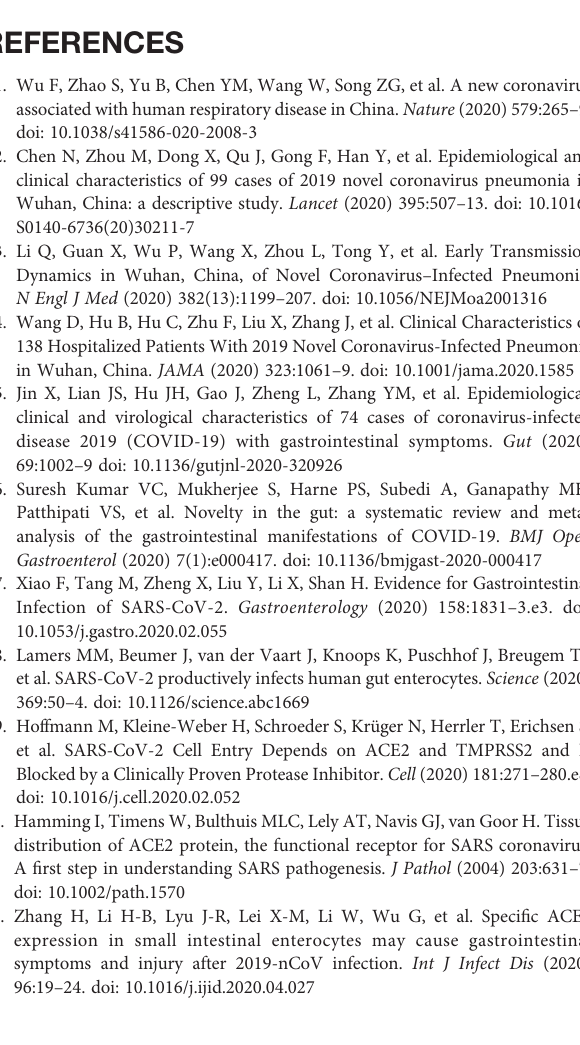
CD45RO + cells among CD3 + CD4 + T cells (C) and CD3 - CD19 + B cells (D) among lymphoidcells.Eachsymbolrepresentsanindividualsubject,n=18 – 80pergroup. Supplementary Figure 2 | Quantitative fl ow cytometry of the expression of the indicated markers strati fi ed according to clinical parameters of COVID-19 patients. (A) Frequency of a 4 + b 7 + and GPR15 + cells among CD3 + CD4 + T cells according to oxygen saturation. (B) Frequency of a 4 b 7 integrin-expressing CD3 + CD4 + CD45RO + memory T cells according to respiratory rate and heart rate. (C) Frequency of IgA-expressing CD3 - CD19 + B cells according to respiratory rate and heart rate. Each symbol represents an individual subject, n = 8 - 18 per group. Supplementary Figure 3 | Lymphocyte subsets in whole blood samples from patients with COVID-19 and healthy controls. Quantitative fl ow cytometry of the frequency (left) and absolute cell numbers (right) of CD3 + (A) , CD3 + CD4 + (B) T cells among lymphoid cells selected based on forward and sideward scatter, CD45RO + cells among CD3 + CD4 + T cells (C) and CD3 - CD19 + B cells (D) among lymphoid cells. Each symbol represents an individual subject, n = 10 – 31 per group. Supplementary Figure 4 | Lymphocyte subsets in whole blood samples from patients with COVID-19 and healthy controls. Representative (left) and quantitative (right) fl ow cytometry of the frequency and absolute cell numbers of CD3 + CD8 + T cells among lymphoid cells selected based on forward and sideward scatter. Each symbol represents an individual subject, n = 10 – 31 per